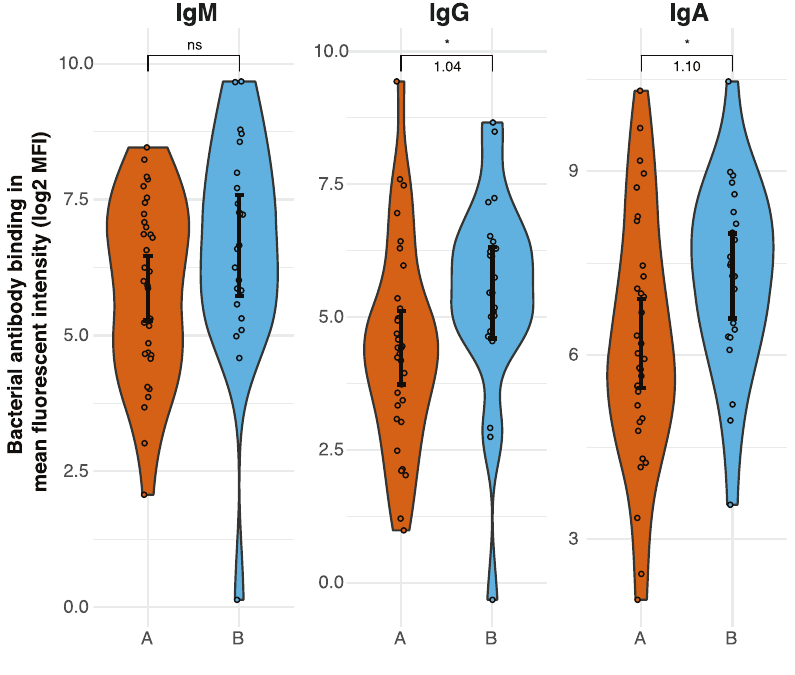
Fig. 2 | Baseline variation in mucosal antibody binding to Bp_mut . Bp_mut , de fi cient for FHA, PRN, and PT, was incubated with heat-inactivated MLF, after which antibody binding to the bacteria was measured by fl ow cytometry. Log2- transformed mean fl uorescence intensity (MFI) of IgM, IgG and IgA binding to Bp_mut in the aP-primed cohorts A and B. Data are N =32 individuals for cohort A